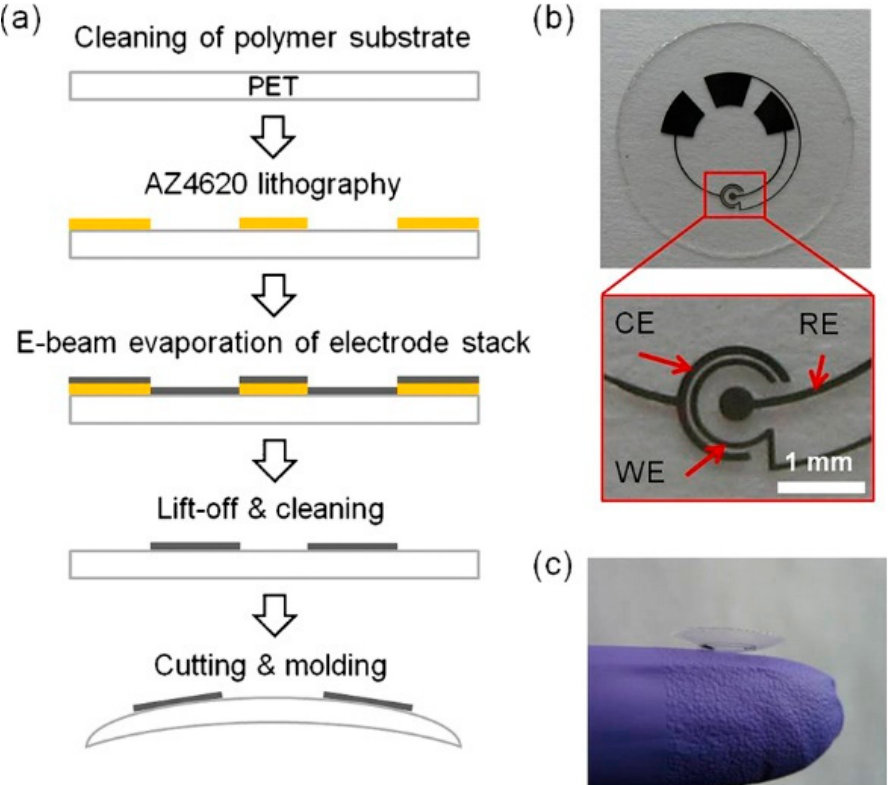
Figure 2. Lactate sensor on a contact lens. ( a ) Schematic representation of the assembly process for sensors on a transparent PET substrate which is molded to a contact lens. ( b ) Flat substrate with sensing structure, interconnects and electrode pads for connection to the external potentiostat; WE—working electrode, CE—counter electrode, RE—reference electrode. ( c ) A completed contact lens sensor held on a finger. Reproduced from [43] with permission from Elsevier.